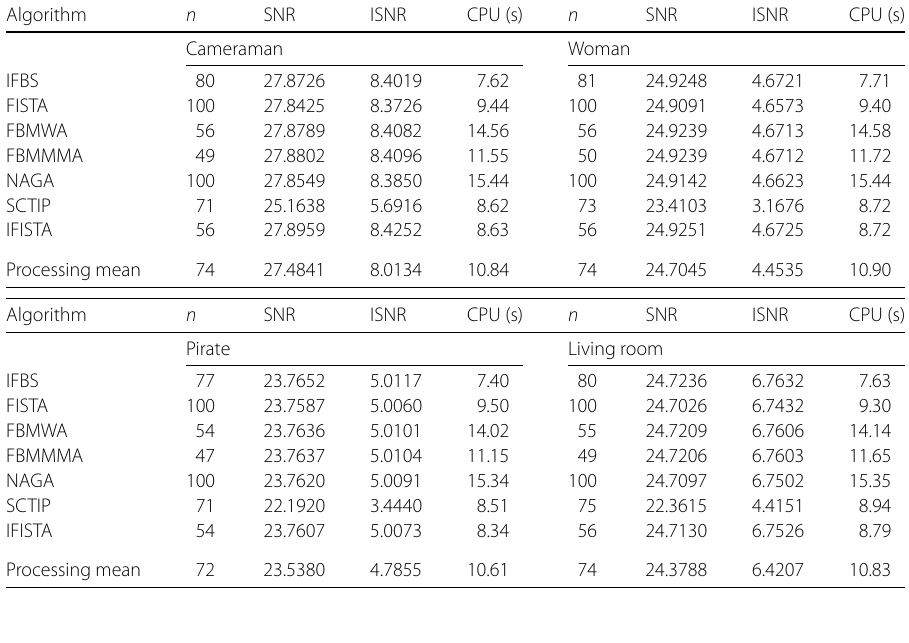
Table 2 The maximum of SNR and ISNR values in first 1 st to 100 th iteration(s) for image